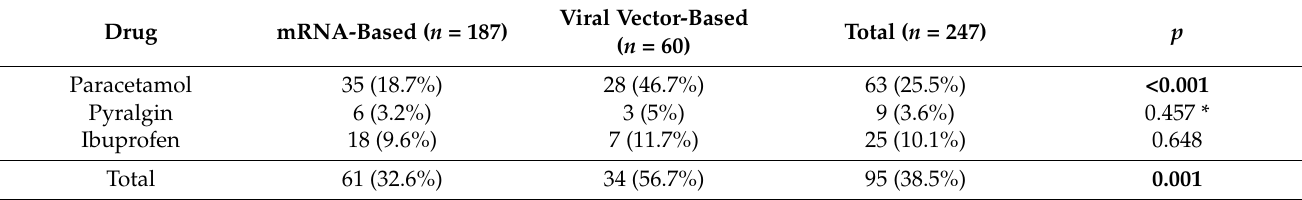
Table 7. Symptoms-relieving drugs after COVID-19 vaccination taken by Polish healthcare